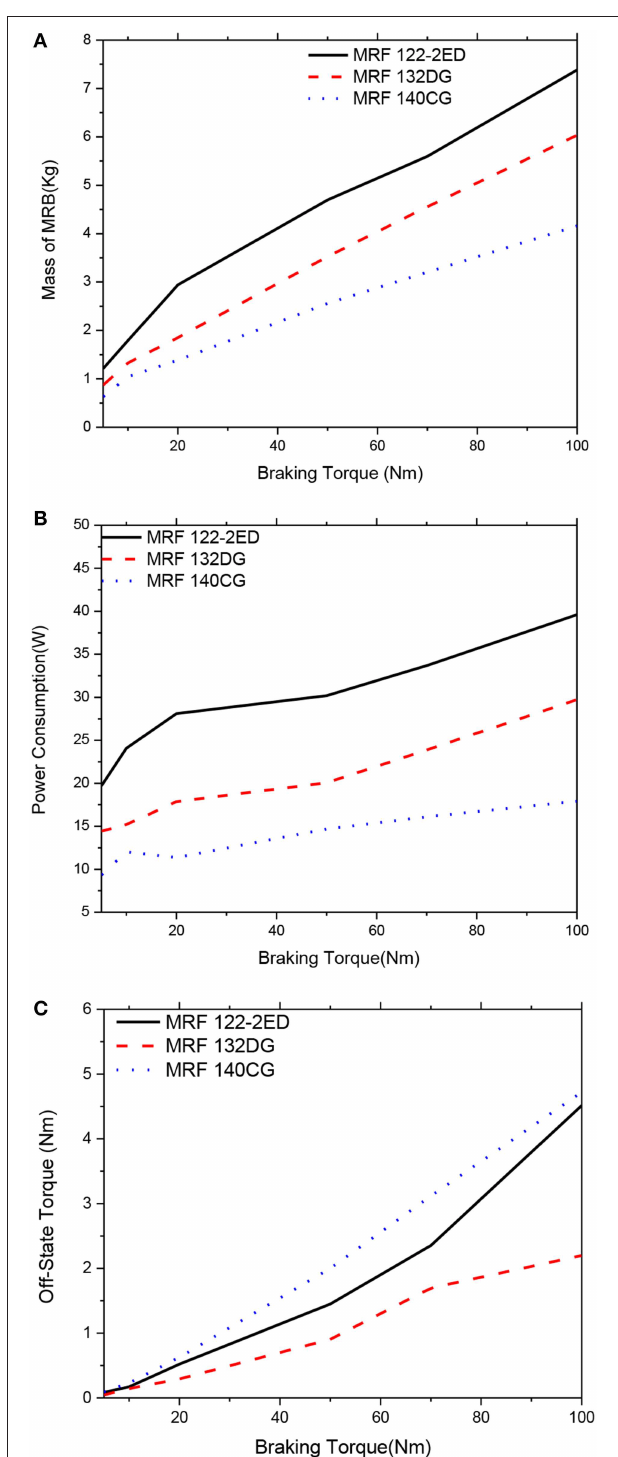
FIGURE 12 | Multi-objective optimization results of the MRBs as a function of braking torque of conventional MRB, α m = α P = α To = 1/3. (A) Mass as a function of braking torque, (B) Power consumption as a function of braking torque. (C) Off-state torque as a function of braking torque.